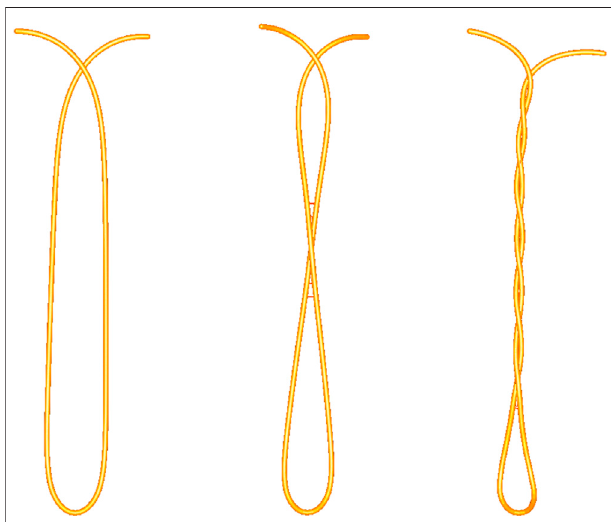
FIGURE 7 | We apply a torsional motion at the end points of the thread. The coupling between bending and torsion allows the formation of